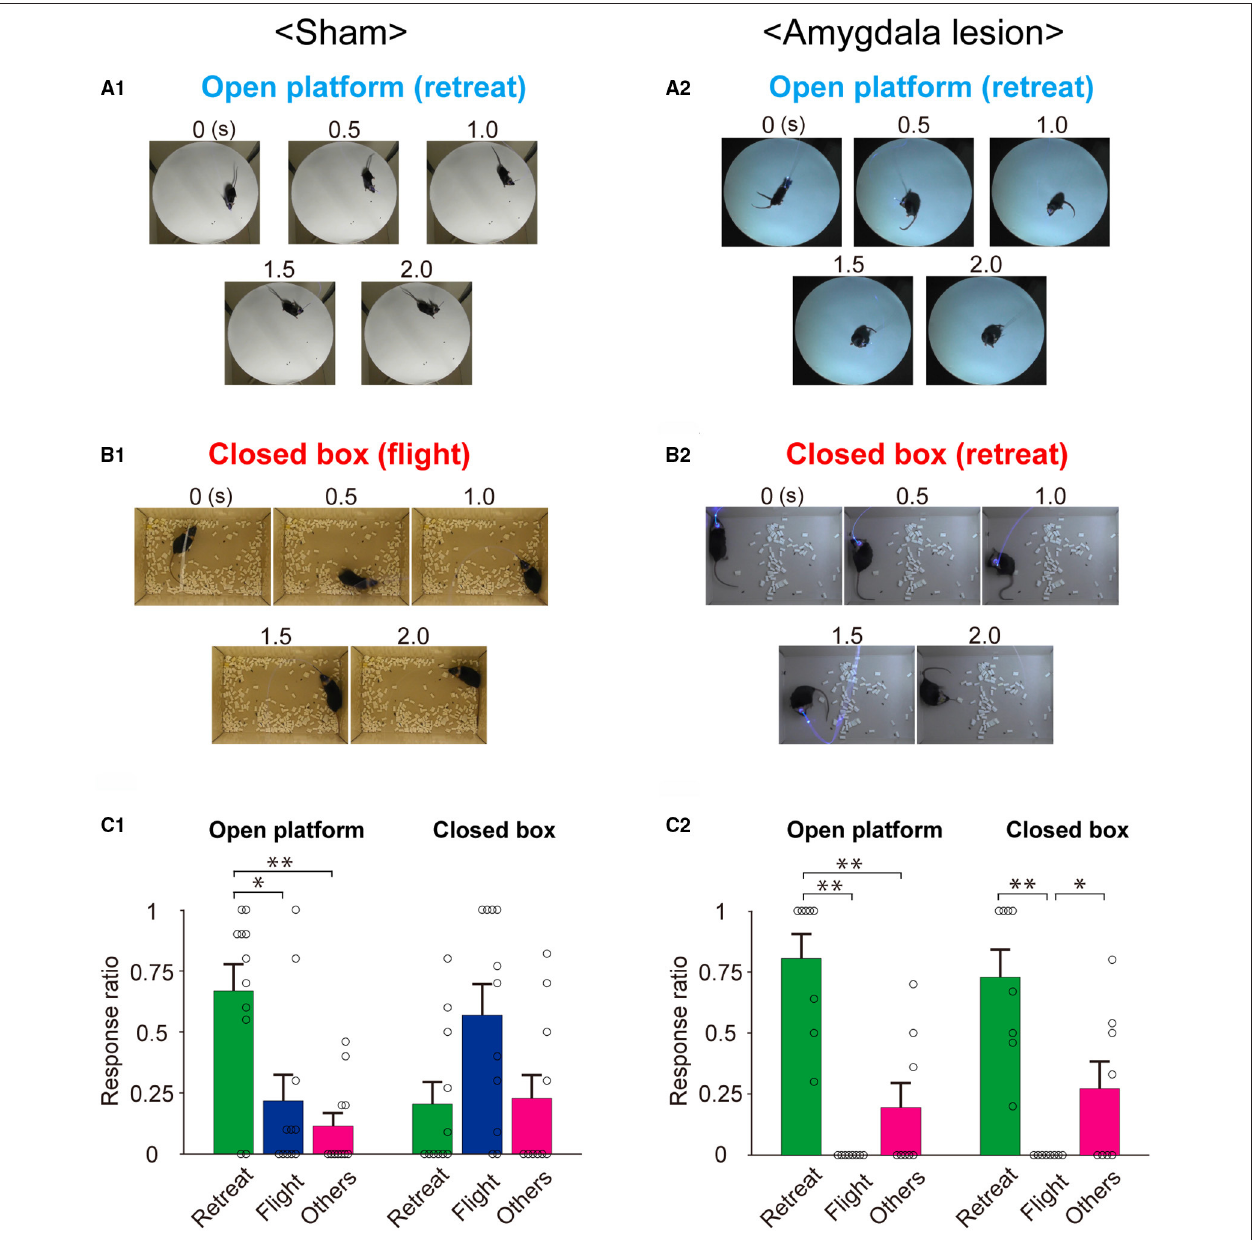
FIGURE 3 | Behavioral responses to optogenetic activation of the SC defense pathway in sham-lesioned and amygdala-lesioned mice. (A,B) Sequential photographs illustrating typical environment-dependent behavioral responses following the optogenetic activation of the SC defense pathway on the open platform (A) and in the closed box (B) in the sham-lesioned (A1,B1) and amygdala-lesioned mice (A2,B2) . (C) Ratios of individual response patterns induced by the optogenetic activation of SC defense pathway on the open platform and in the closed box in the sham-lesioned [ (C1) , n = 11] and amygdala-lesioned [ (C2) , n = 8] mice (* p < 0.05, ** p < 0.01, Bonferroni’s multiple comparison